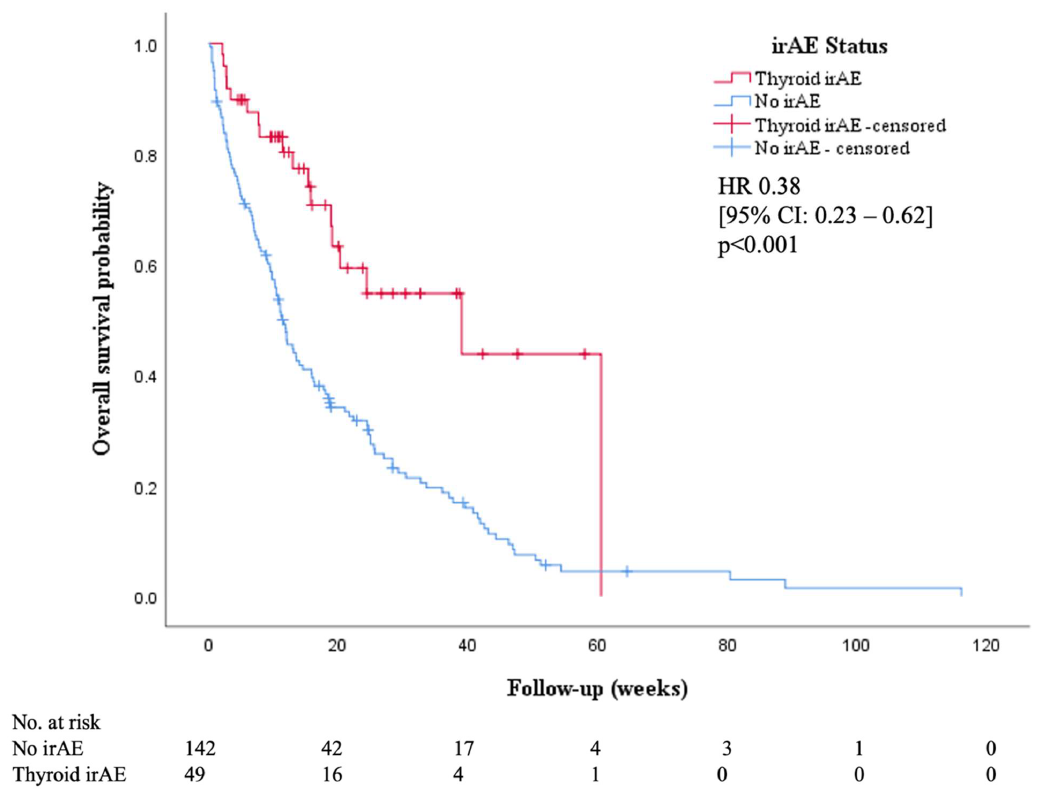
Figure 3. Kaplan–Meier curves for overall survival according to thyroid irAE status .